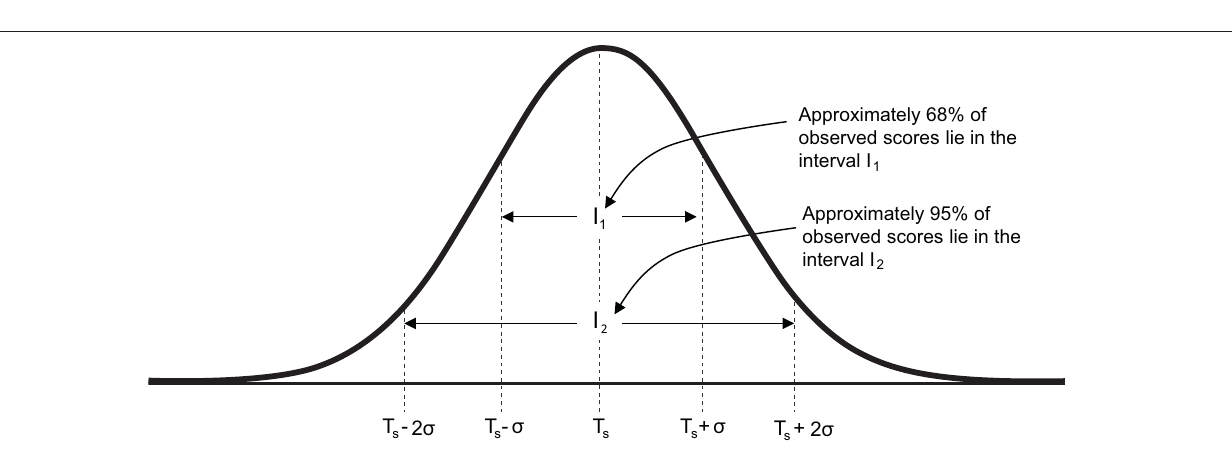
FIGURE 2 | Graphical representation of the normal distribution of observed scores centered on true score. Ts, true score; σ standard deviation of repeated observed scores [also referred to as typical error